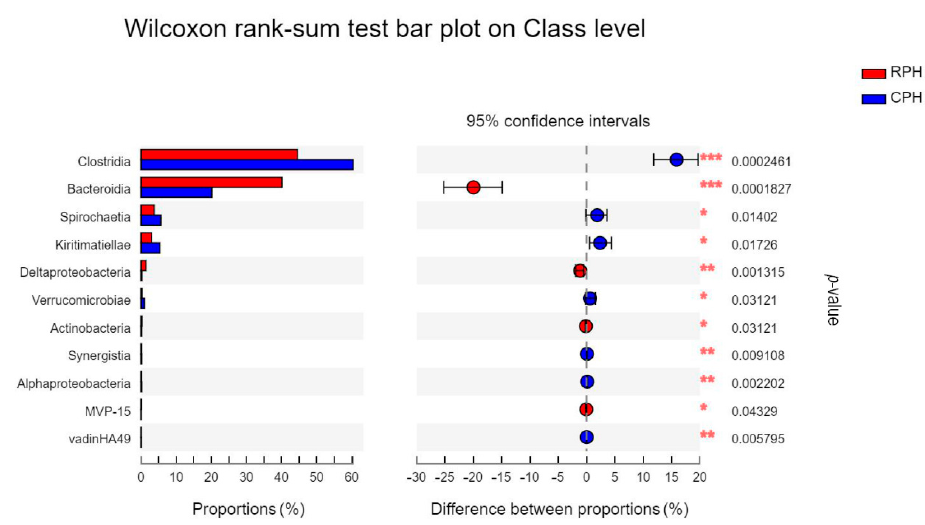
Figure 9. The bar plot shows the bacterial order with significant differences among the CPH and Figure 7. The bar plot shows the bacterial class with significant differences among the CPH and RPH. * p < 0.05, ** p < 0.01 and *** p < 0.001.